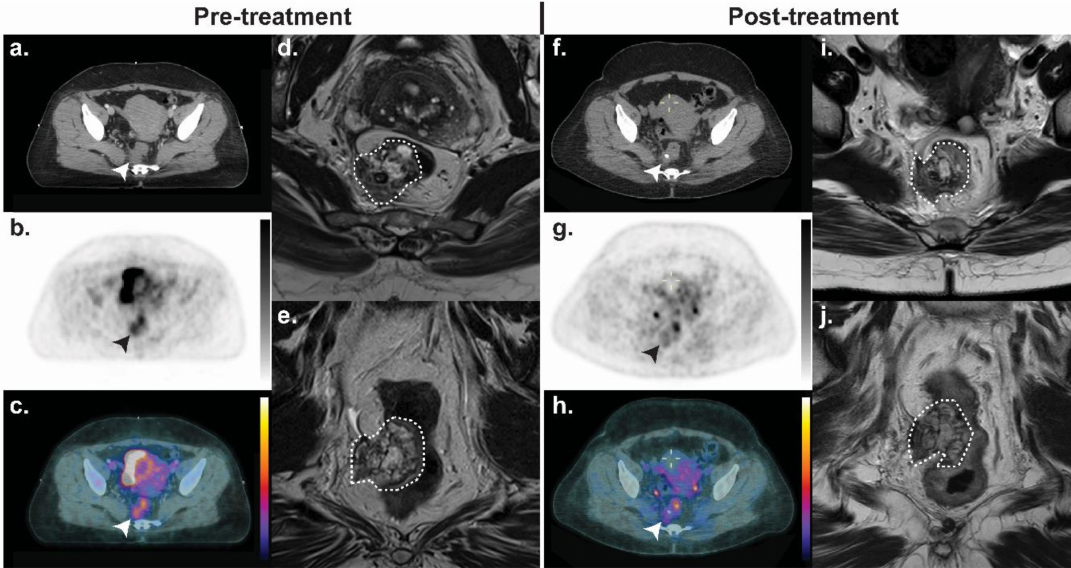
Figure 5. A T4N0M0 rectal adenocarcinoma treated with neoadjuvant chemoradiotherapy. ( b and c ) Prior to treatment, the lesion is 18 F-FDG-avid; ( g and h ) after chemoradiation, there is minimal residual uptake despite a minimal change in tumour volume. At subsequent resection, no residual disease remained and the patient was down-staged to ypT0N0M0. ( a and f ) axial CT; ( b and g ) axial 18 F-FDG-PET; ( c and h ) PET/CT fusion; ( d and i ) axial T 2 W MRI; ( e and j ) coronal T 2 W MRI. The tumour is indicated by arrowheads and dashed outline. All 18 F-FDG-PET images are scaled between an standardised uptake value (SUV) of